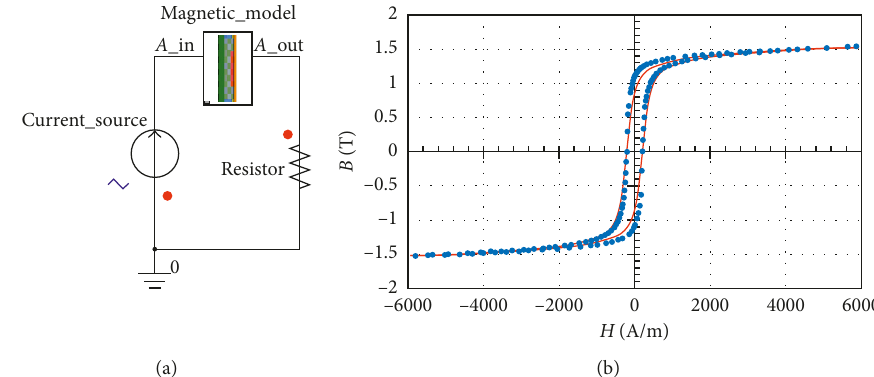
Figure 6: External circuit model and magnetisation curve: 11SMn30 (curve fit vs data). (a) External circuit. (b) B-H